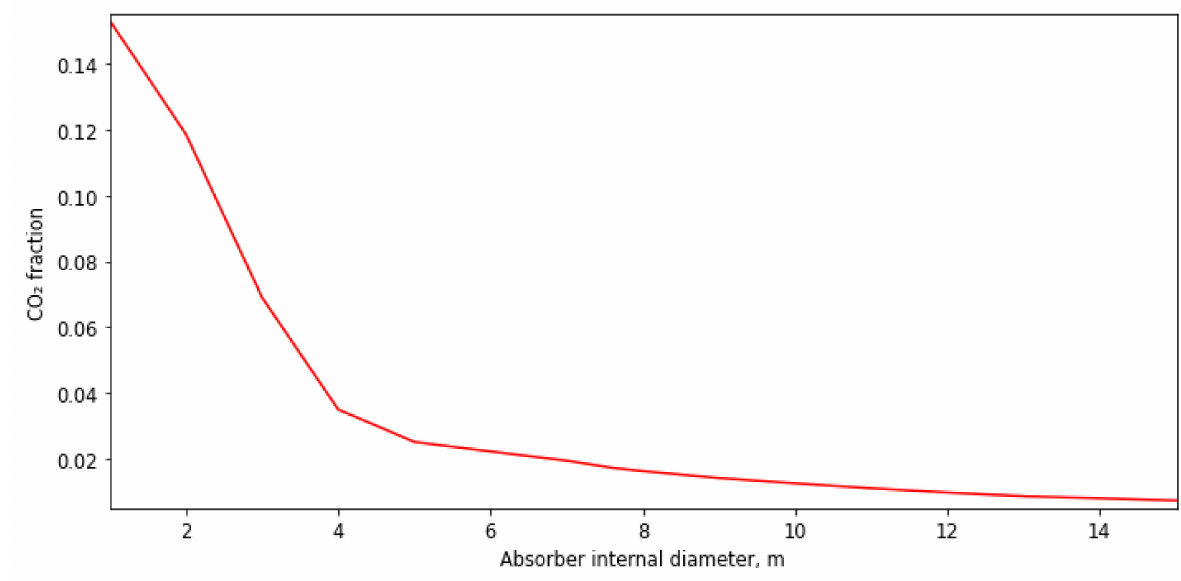
Figure A2. Change of CO 2 composition with various column